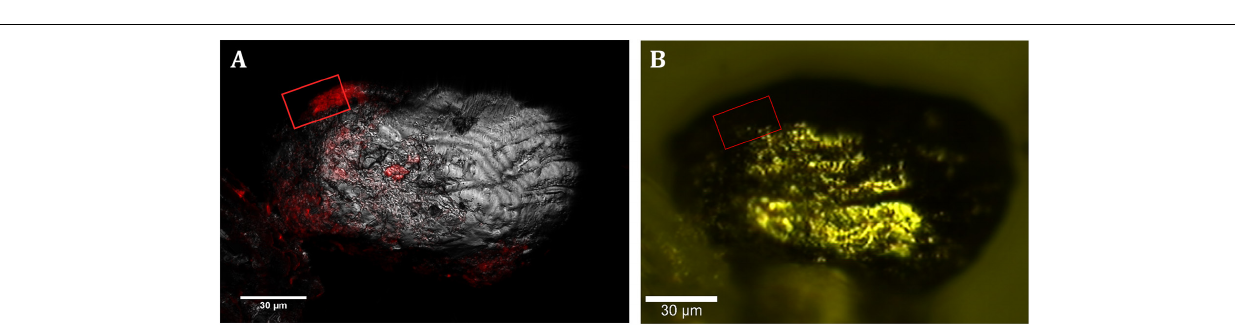
FIGURE 3 | CLSM and CRM correlation. (A) Localization of members of Acidovorax spp. (red) attached to a mineral particle (in gray, reflection) at –228.6 m by CARD-FISH/CLSM. (B) Same mineral particle located in the CRM. Area analyzed by CRM is indicated by a red square. Scale bars, 30 µ m.